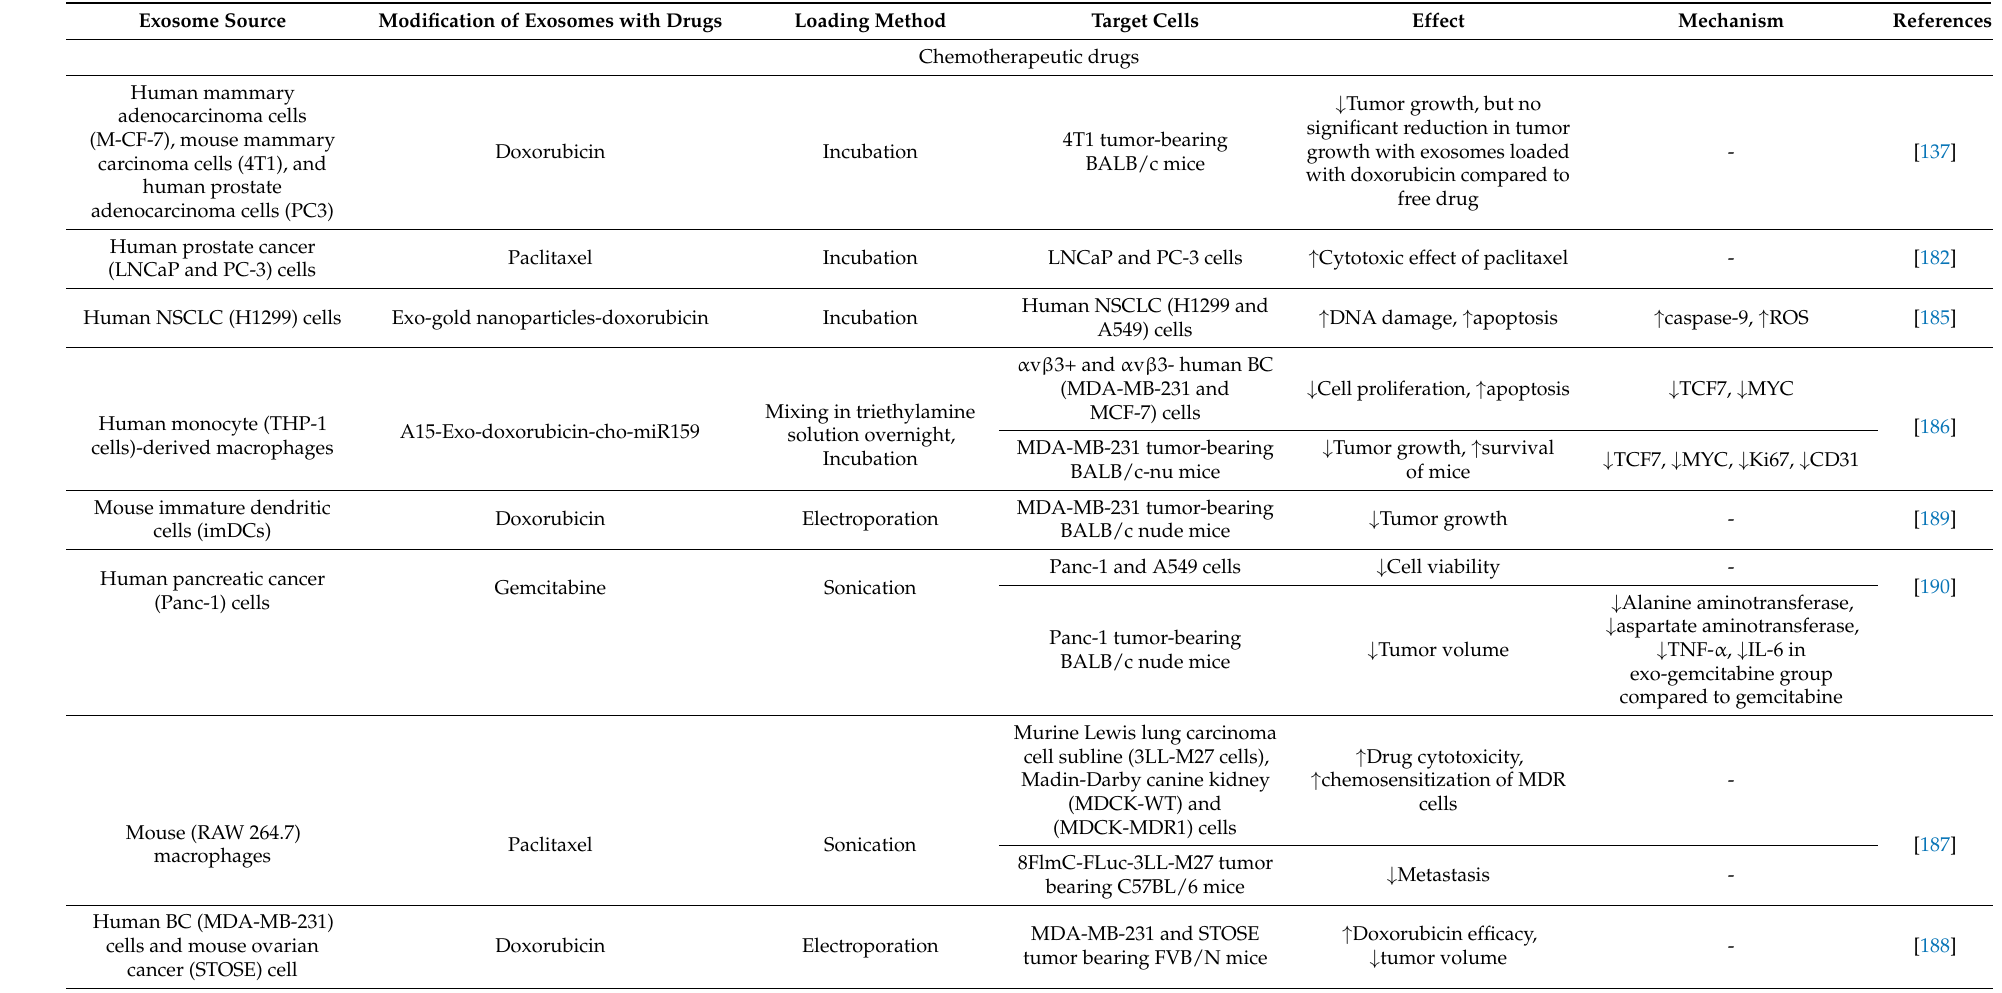
Table 3. Exosomes as delivery system for therapeutic implications against